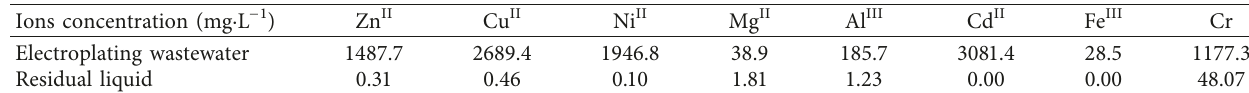
Table 3: The metal ions concentration of the electroplating wastewater and remaining metal ions concentration of residual liquid. Ions concentration (mg · L − 1 )